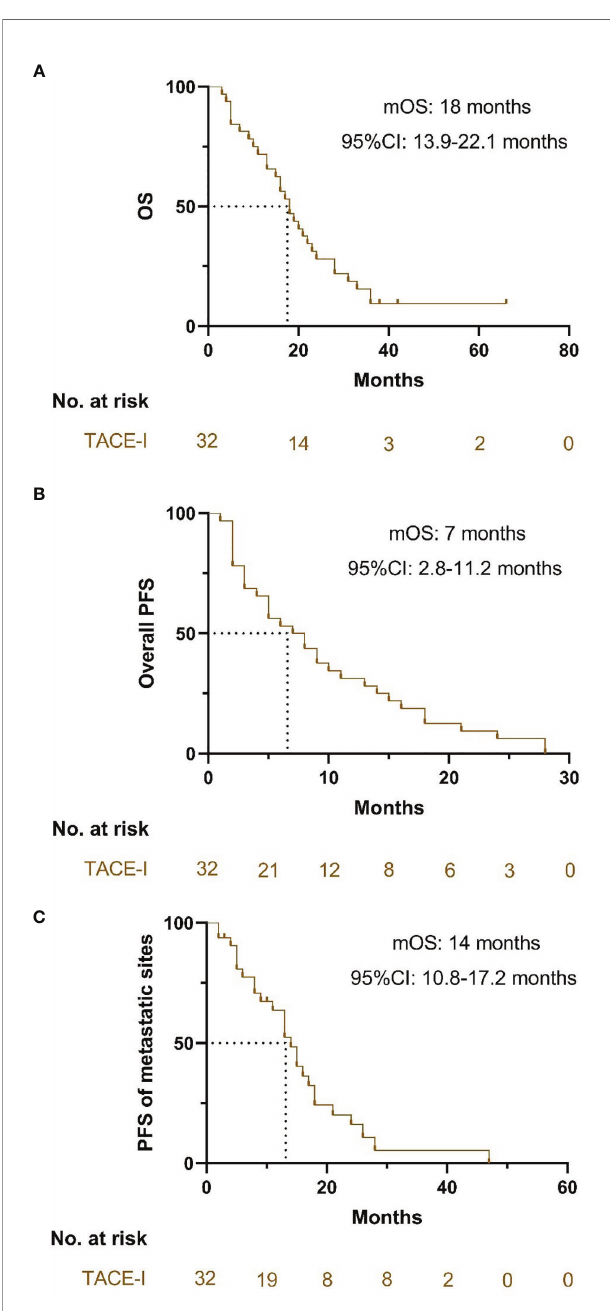
FIGURE 3 | Kaplan-Meier curves for OS, PFS and PFS of metastatic sites. (A) Kaplan-Meier curves for OS; (B) Kaplan-Meier curves for PFS; (C) Kaplan- Meier curves for PFS of the metastatic sites.